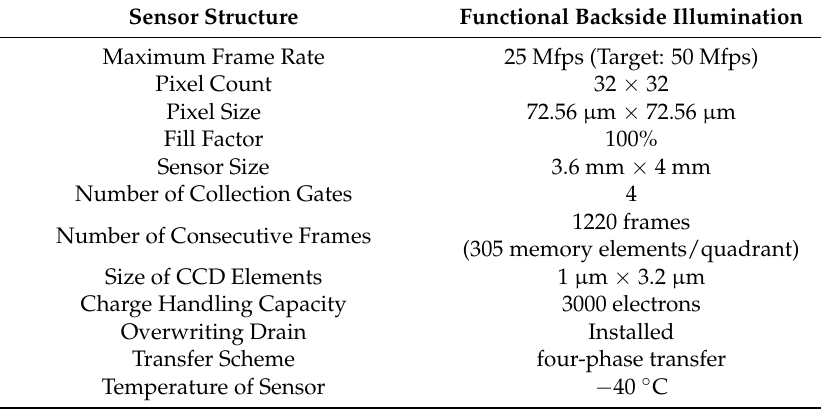
Table 1. Specifications of the test backside-illuminated multi-collection-gate image signal accumulation sensor (BSI MCG